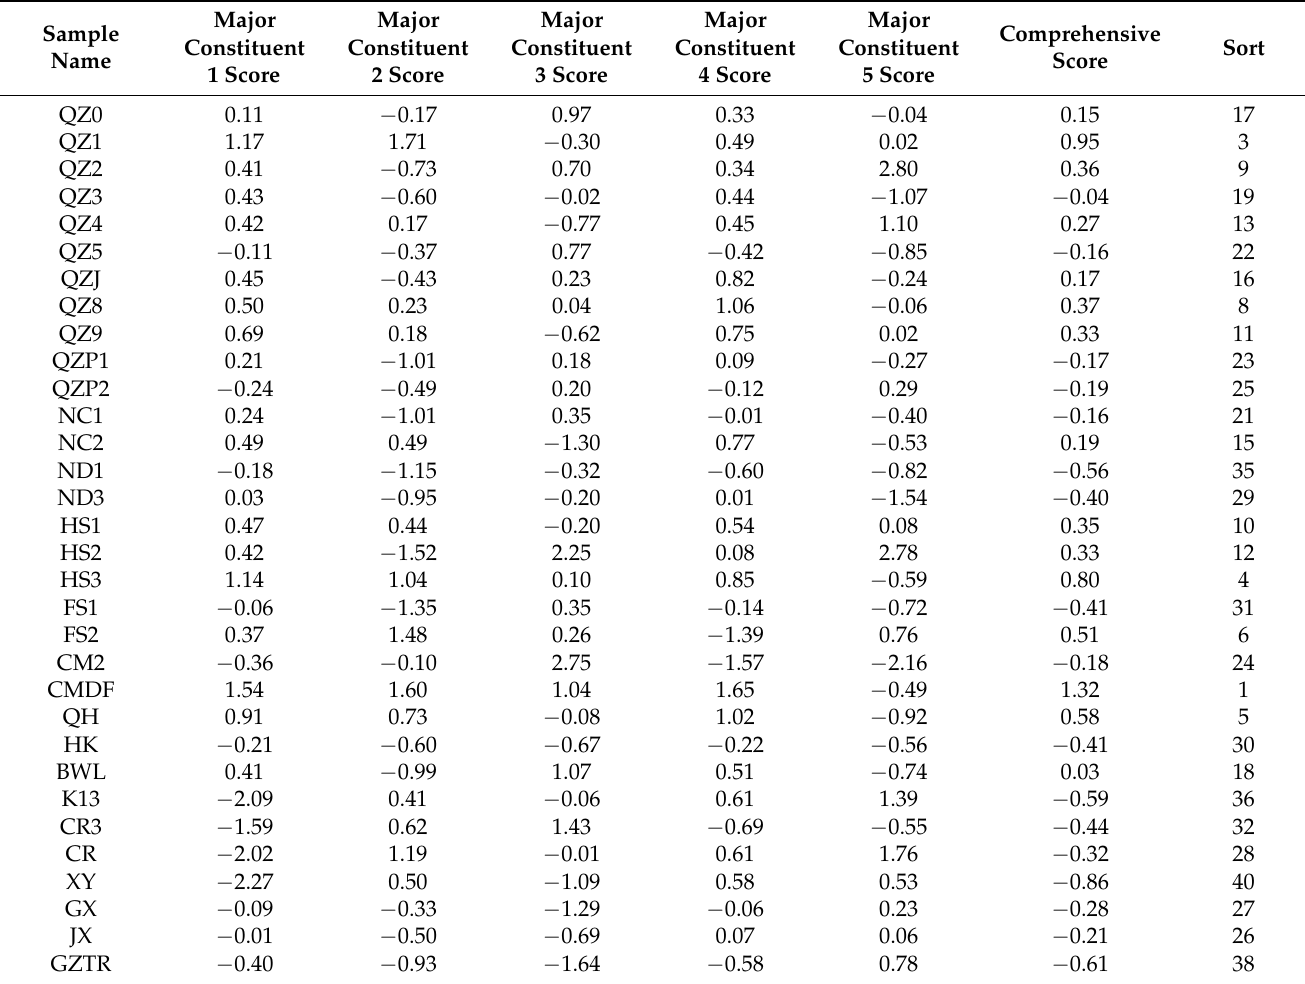
Table 5. Comprehensive score and ranking of 40 kinds of Camellia spp.